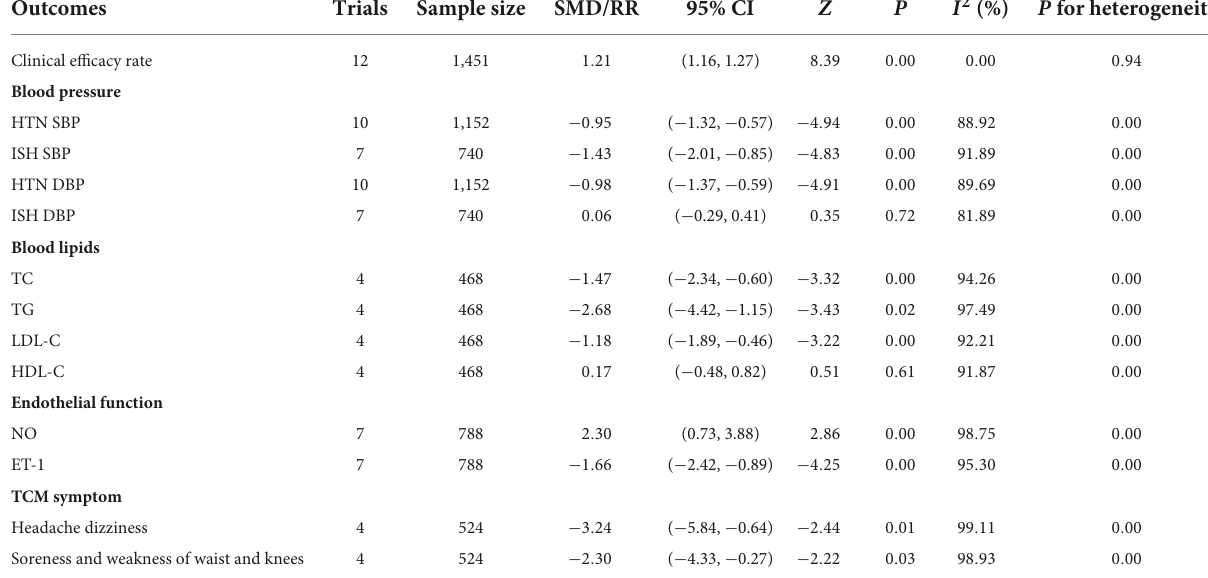
TABLE 2 Calculation results of the meta-analysis. Outcomes Trials